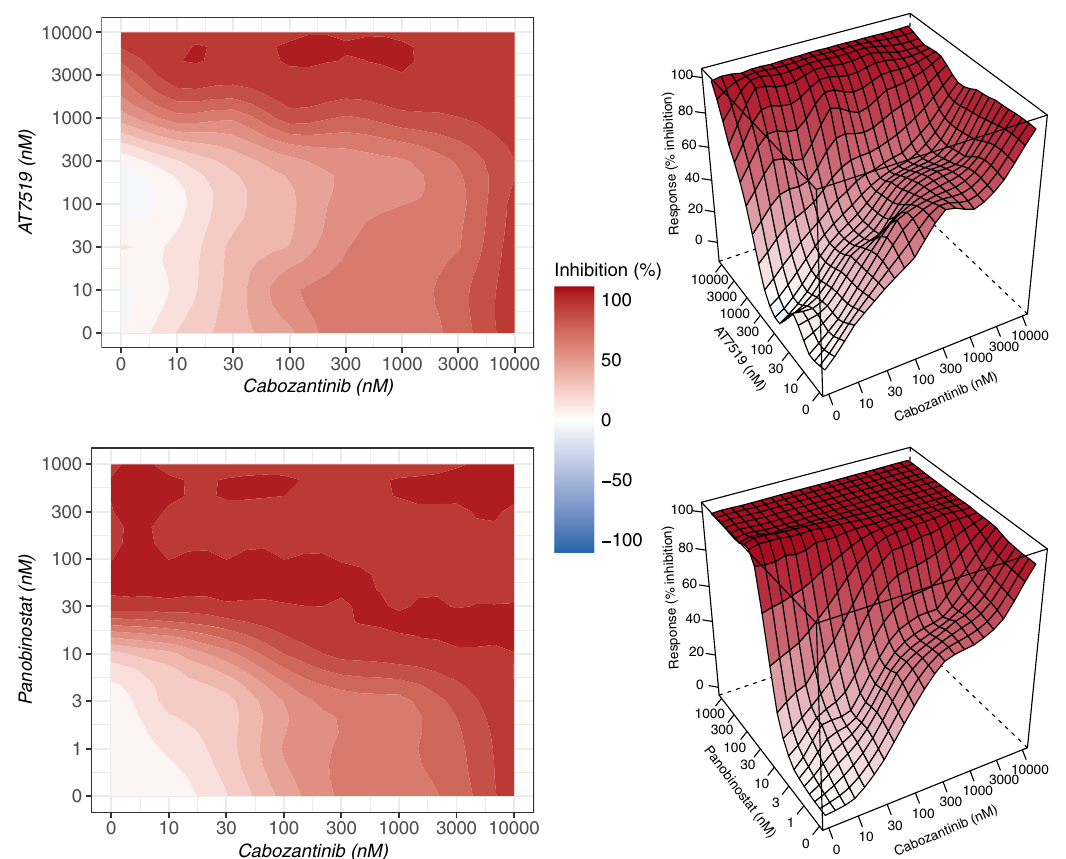
Fig. 9 The top synergistic drug combinations identi fi ed in the positive group. These matrices represent the highest synergistic combination based on four measures of synergy. HSA and LOEWE methods indicate that the cabozanitinb and AT7519 combination is the highest synergistic combination. The combination of cabozanitinb and panobinostat is the most synergistic based on ZIP and Bliss measures. For each combination, the sensitivity landscapes are shown in both 2D and 3D. The complete sensitivity landscapes for all 135 drug combinations can be found in Supplementary Fig. 2. Source data are provided as a Source Data fi